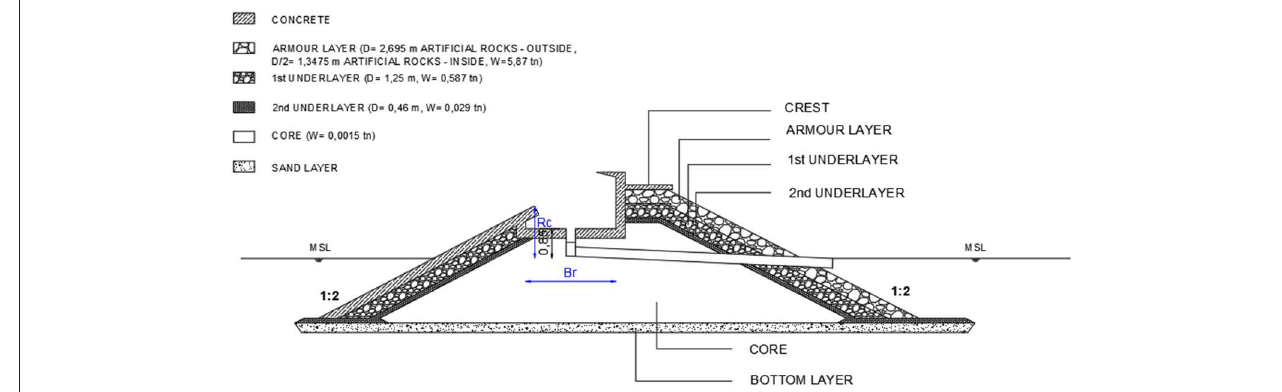
FIGURE 3 | Graphical demonstration of a typical energy breakwater